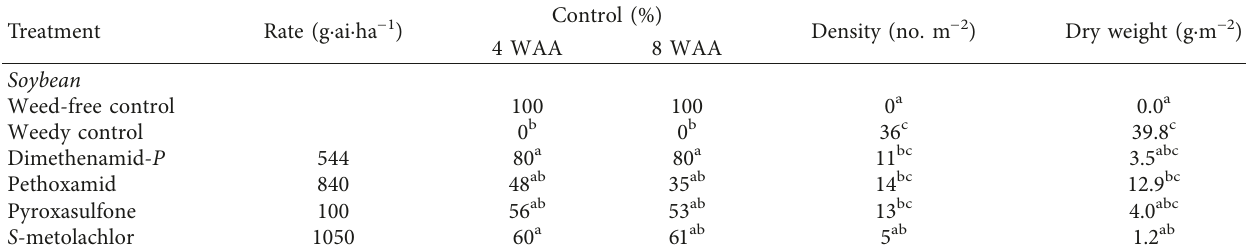
Table 7: Control, density, and dry weight of barnyardgrass treated with VLCFA inhibitor herbicides, applied preemergence (PRE), in soybean near Exeter (2017) and Ridgetown (2017) a